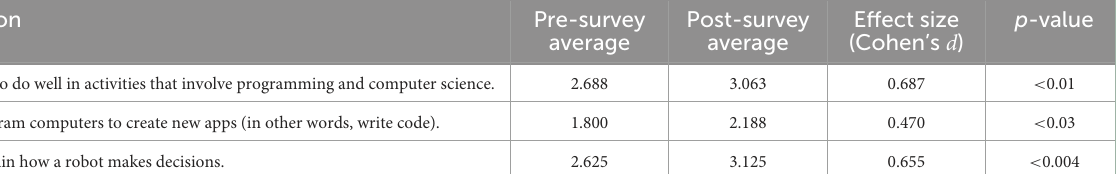
TABLE 2 Significant pre-survey and post-survey differences.